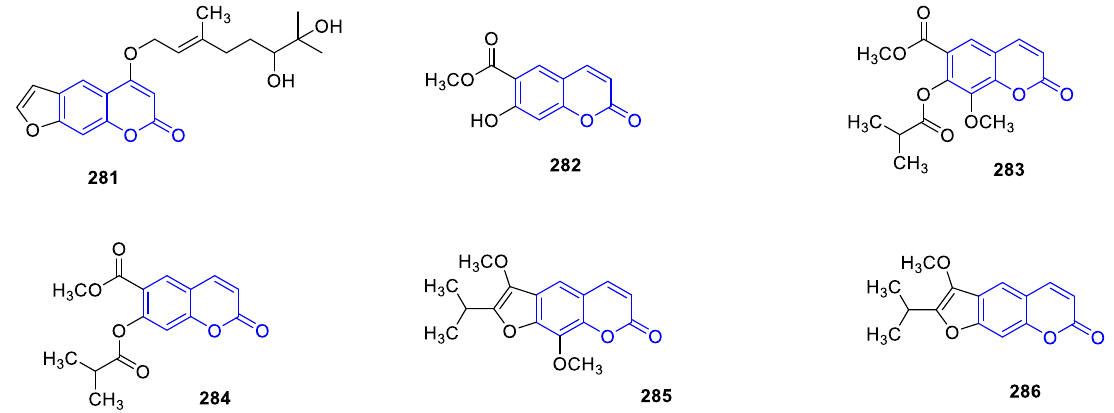
Figure 12 . Coumarins moieties where isolated from P. luxurians 6′,7′ -dihydroxybergamottin 281 , officinalin 282 , stenocarpin isobutyrate 283 , officinalin isobutyrate 284 , 8-methoxypeucedanin 285 , and peucedanin 286 .